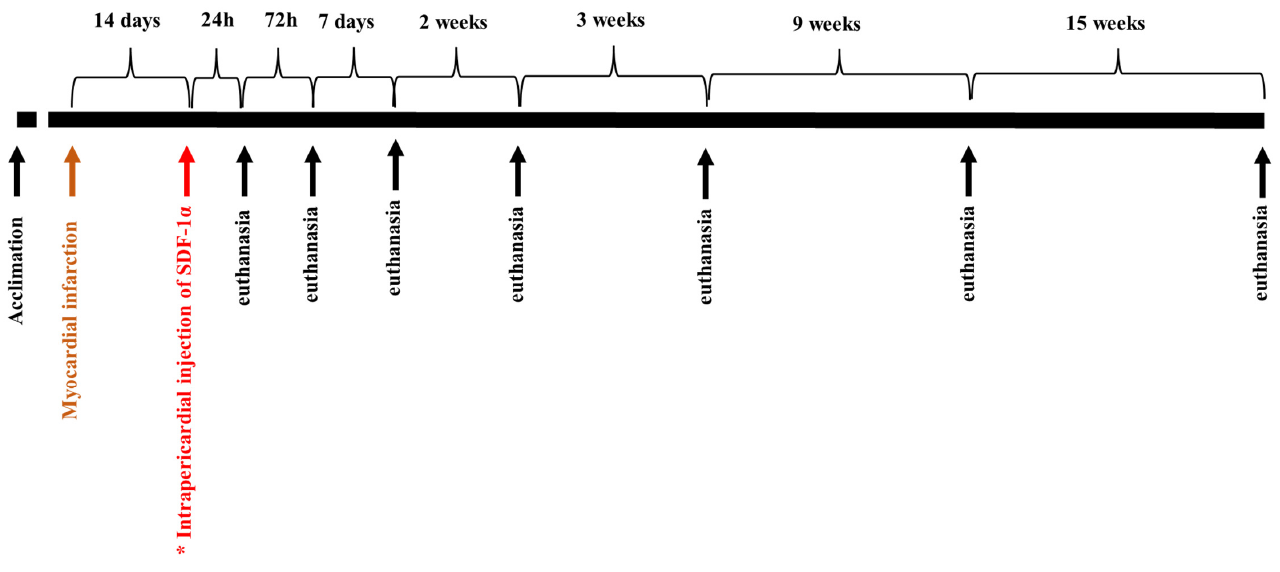
Figure 2. The scheme of the experiment. In the study group (*), SDF-1 α -released microspheres were delivered to the pericardial sac 14 days after the myocardial infarction. Control animals did not receive microspheres after MI. The animals were euthanized 24 h, 72 h, 7 days, 14 days, 3 weeks, 9 weeks, and 15 weeks after microspheres